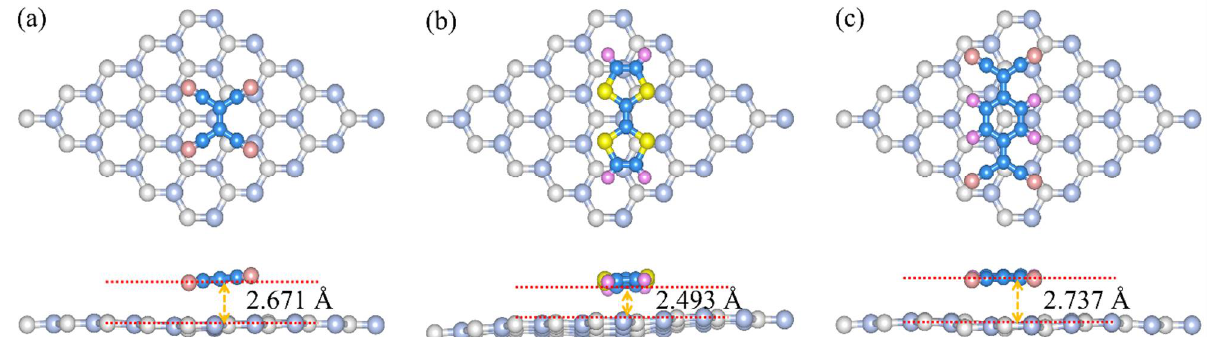
Figure 2. The optimized ground state atomic structures of the most stable configurations of the ( a ) TCNE, ( b ) TTF, or ( c ) TCNQ molecules adsorbed g − ZnO systems. The upper is the top view, and the bottom is the side. Table 1. Adsorption energy ( E ad ), doping bandgap ( E g ), adsorption height ( h ), charge transfer ( ∆ Q ), and injected carrier concentration ( n ) for the most stable configurations of TCNQ, TTF, or TCNQ molecules adsorbed on g − ZnO.